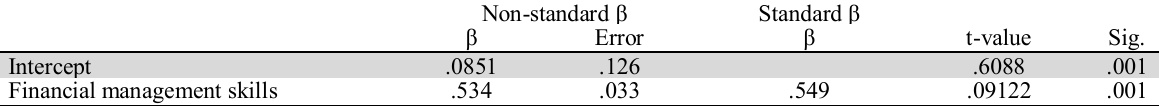
The summary of regression analysis for the third hypothesis